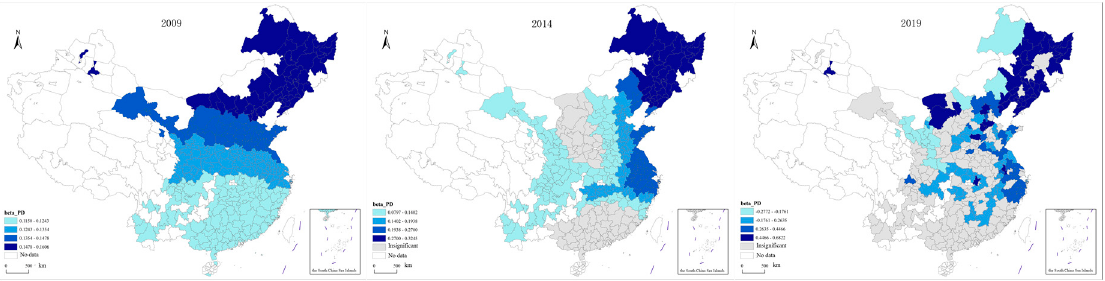
Figure 5. Spatial distribution of population density indicator